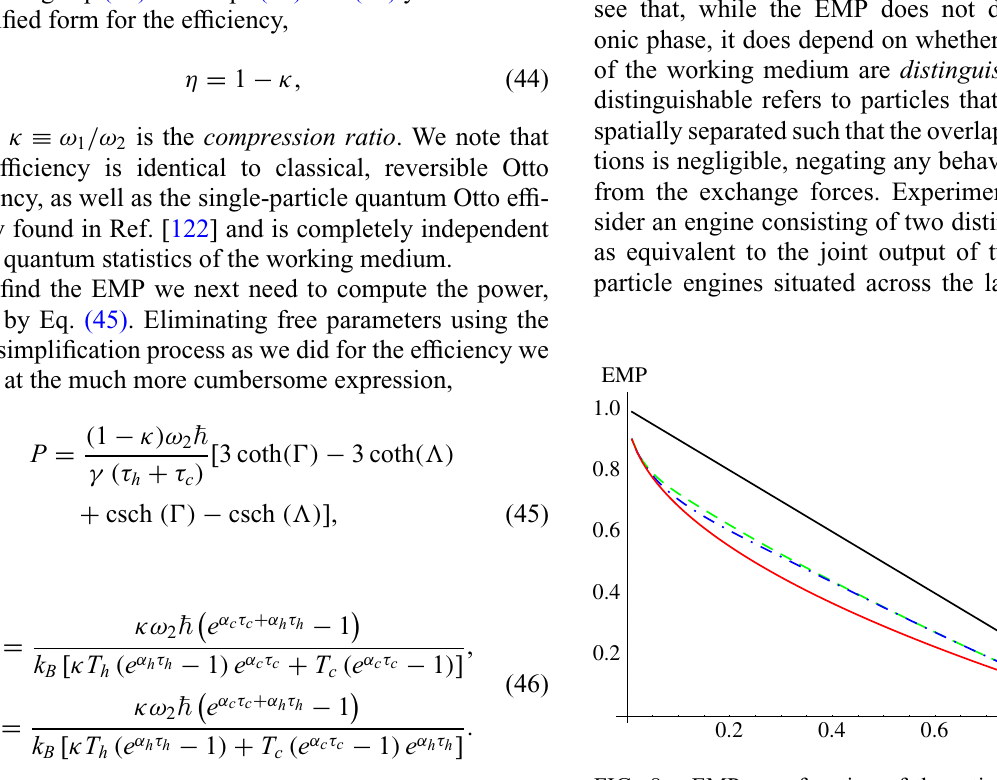
FIG. 8. EMP as a function of the ratio of bath temperatures for two distinguishable quantum particles (dot dashed, blue) and two indistinguishable statistical anyons (dashed, green) in one dimension. The Curzon-Ahlborn efficiency (bottom solid, red) and the Carnot efficiency (top solid, black) are given in comparison. Operation is in the quantum regime correspond- ing to (cid:2) ω 2 / k B T c = 10. Parameters are α c = α h = γ = 1, and τ = τ = c h